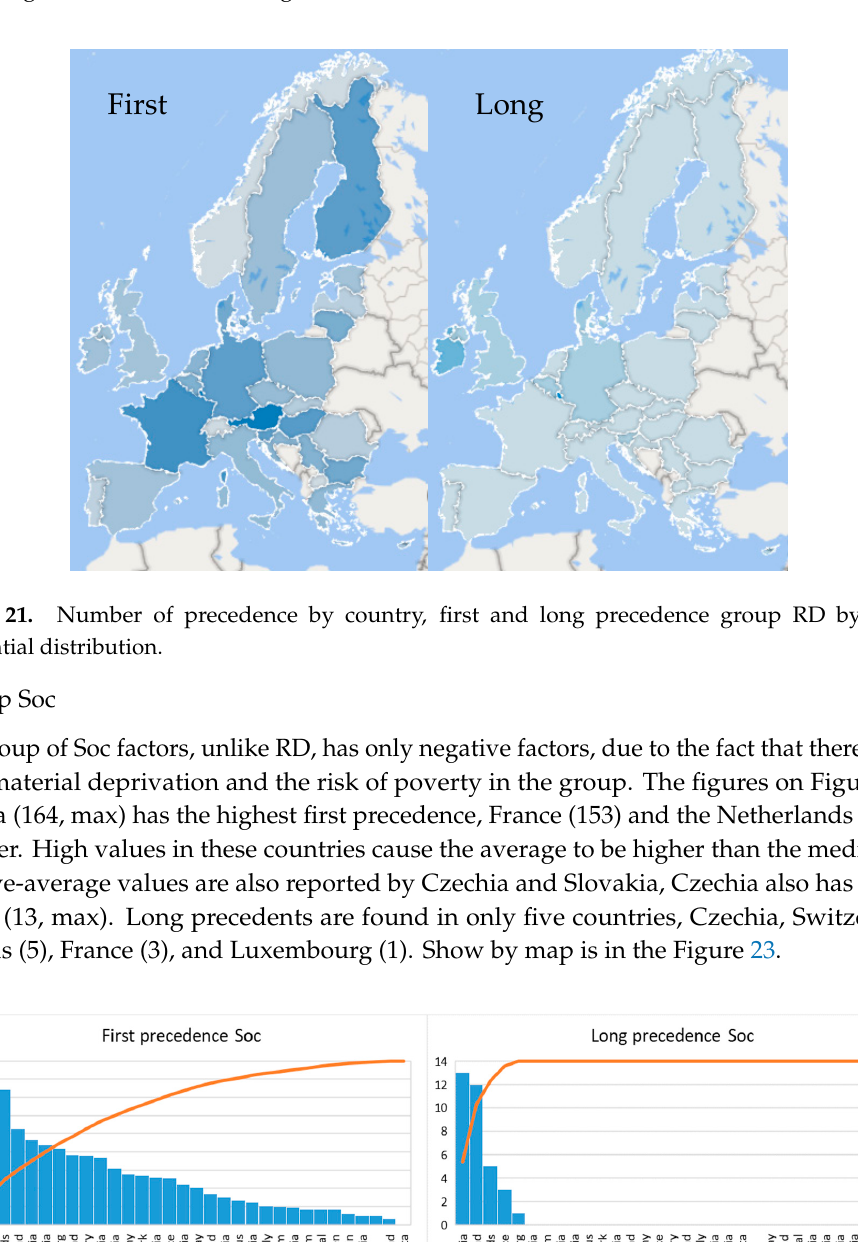
Figure 20. Number of precedence by country, first and long precedencies group RD.